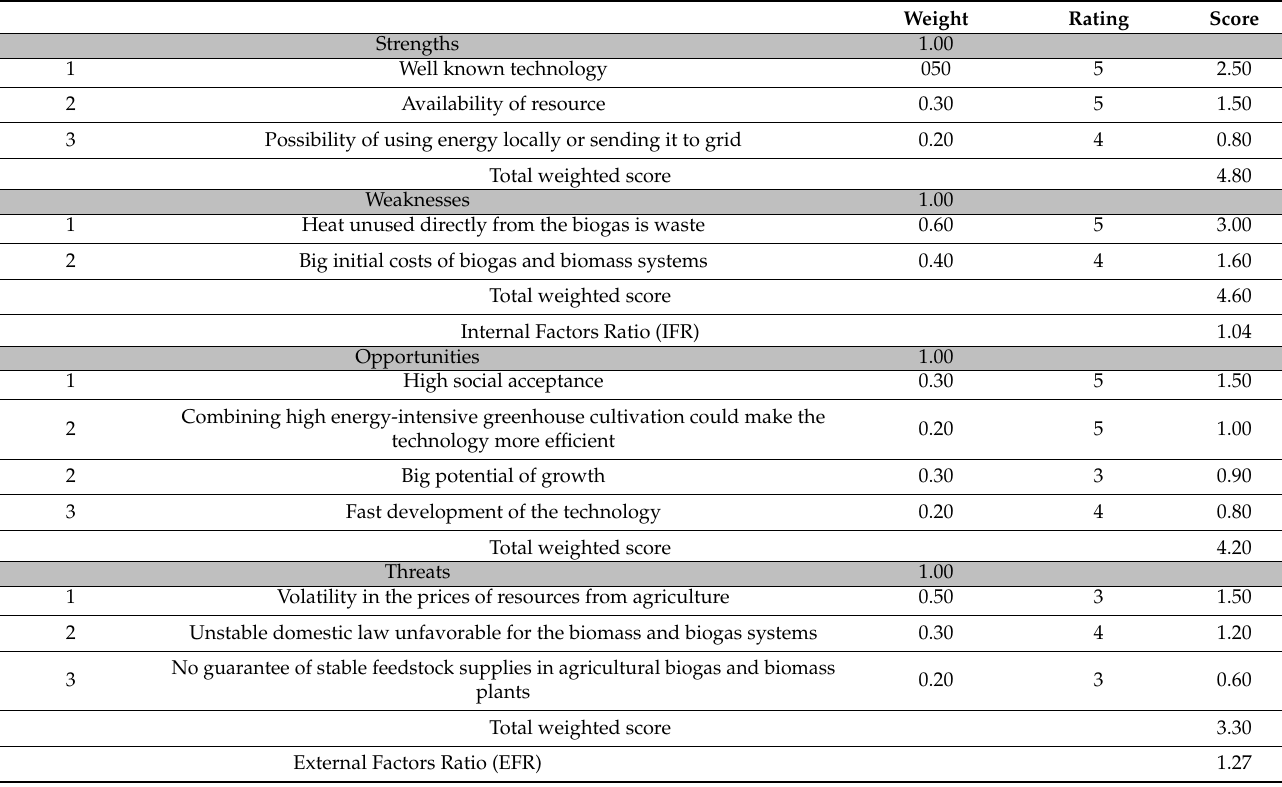
Figure 9. Location of biogas and biomass systems in Poland. Table 7. SWOT analysis for biogas and biomass systems in Poland.